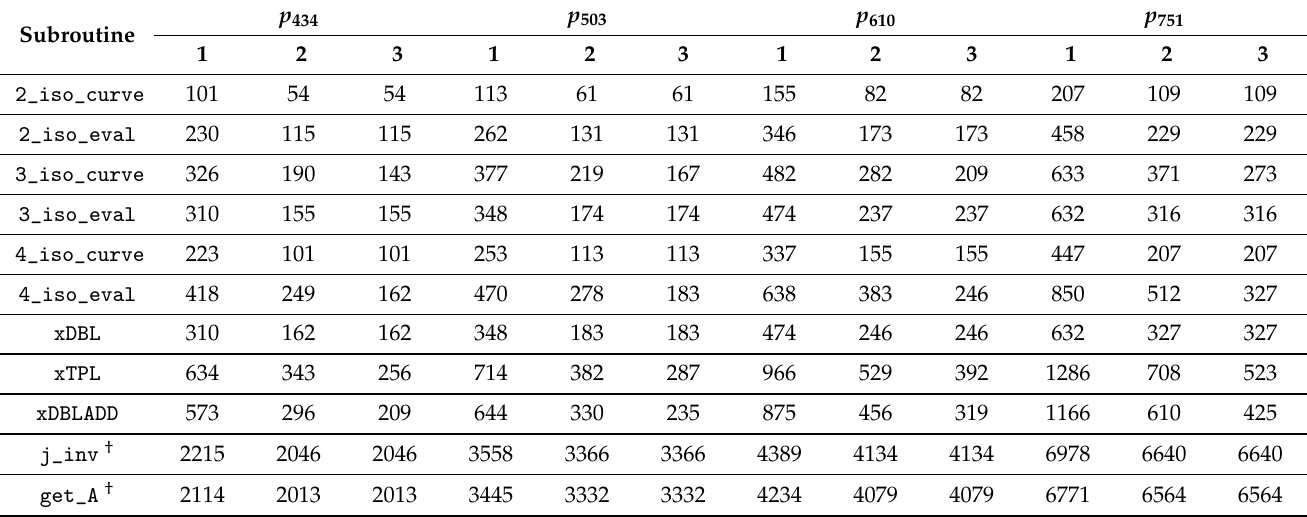
Table 5. An overview of the latency associated with the primary subroutines (in clock